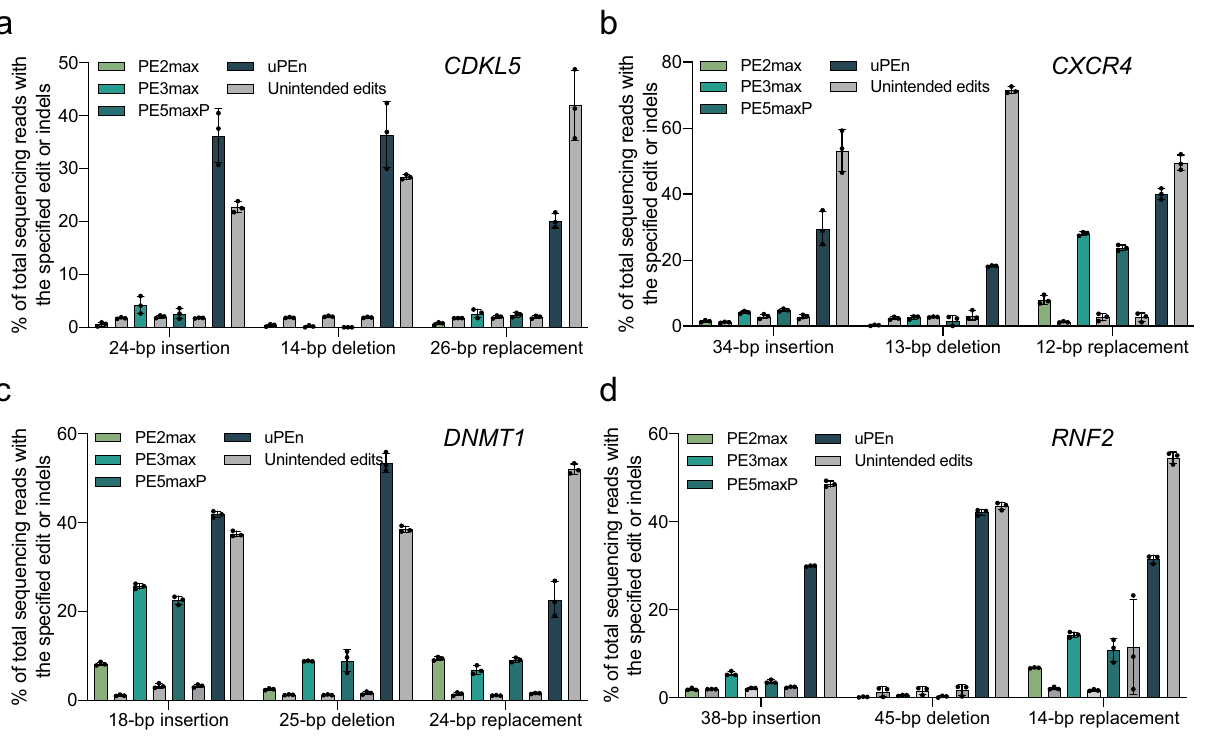
RNF2 ( d ) loci in HEK293T cells. The levels of corresponding unintended edits are shown in grey bars. Values and error bars re fl ect the mean and s.d. of three bio- logical replicates. Source data are provided as a Source Data fi